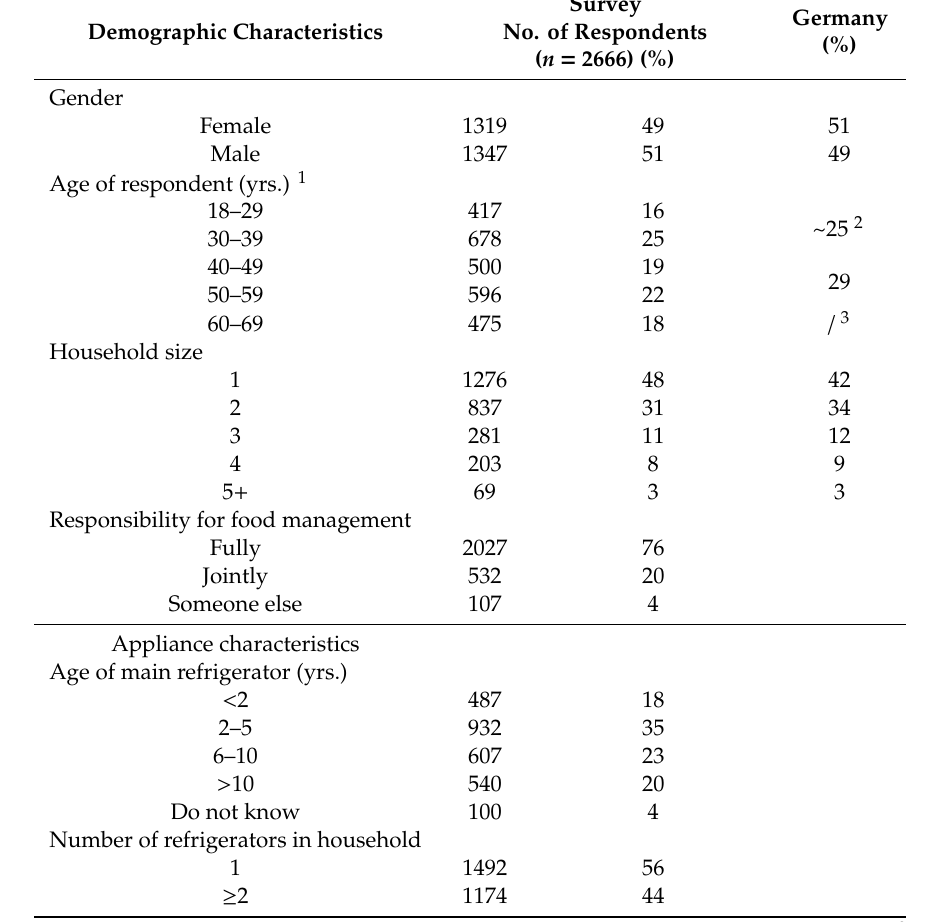
Gender distribution was almost 1:1. Almost 50% of the respondents lived in single-person households, approximately one third (30%) in two-person households and 22% in larger